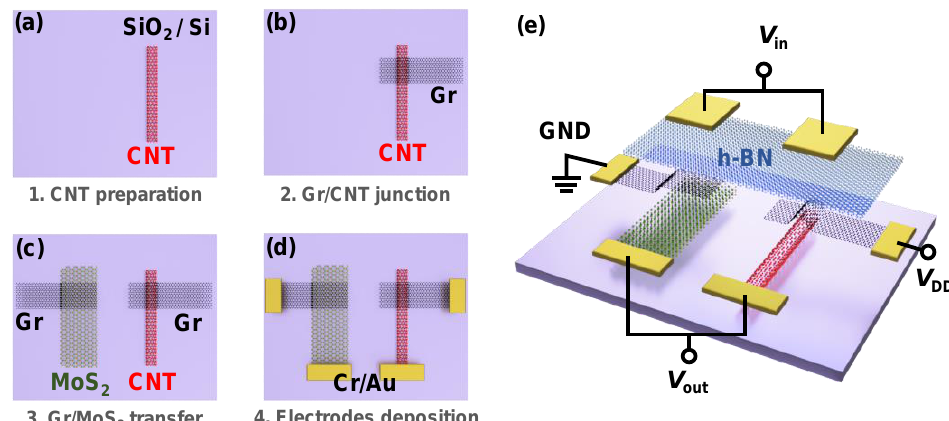
Figure 1. Fabrication processes of a complementary inverter based on Gr/CNT and Gr/MoS 2 barristors. ( a ) A semiconducting CNT is transferred from a quartz to a SiO 2 (300 nm)/Si substrate. ( b ) A Gr/CNT junction is formed by the transfer of graphene onto the CNT. ( c ) A Gr/MoS 2 junction, prepared on a different substrate, is moved next to the Gr/CNT junction. ( d ) Metal (Cr/Au)